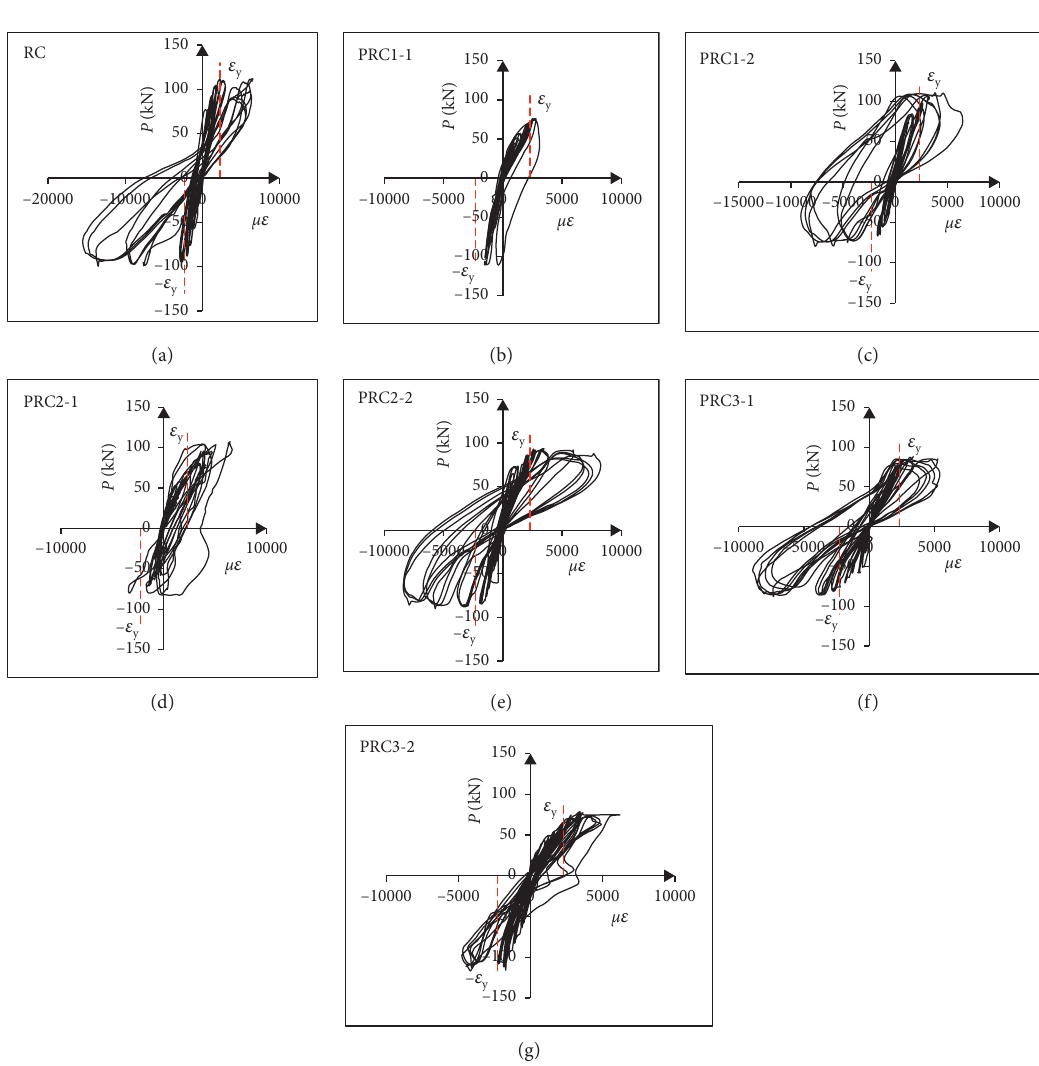
Figure 7: Hysteretic curves of longitudinal reinforcement strain versus horizontal load.